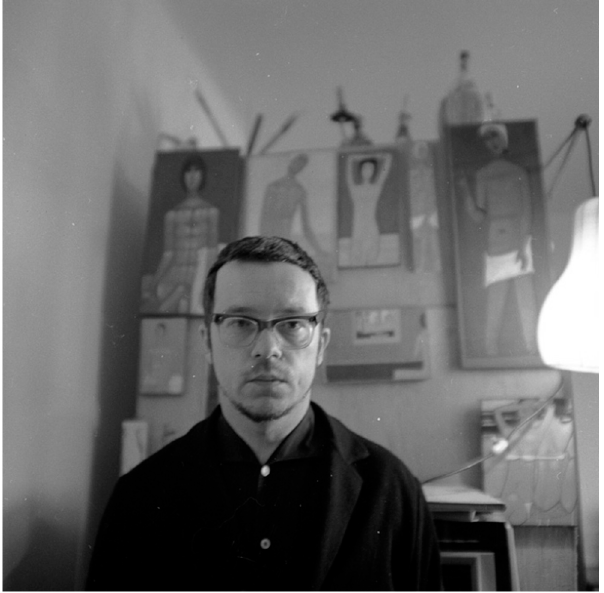
Figure 1. Jerzy Nowosielski in 1966. Museum of Modern Art in Warsaw. Photo by Eustachy Kossakowski. Reproduced with permission.